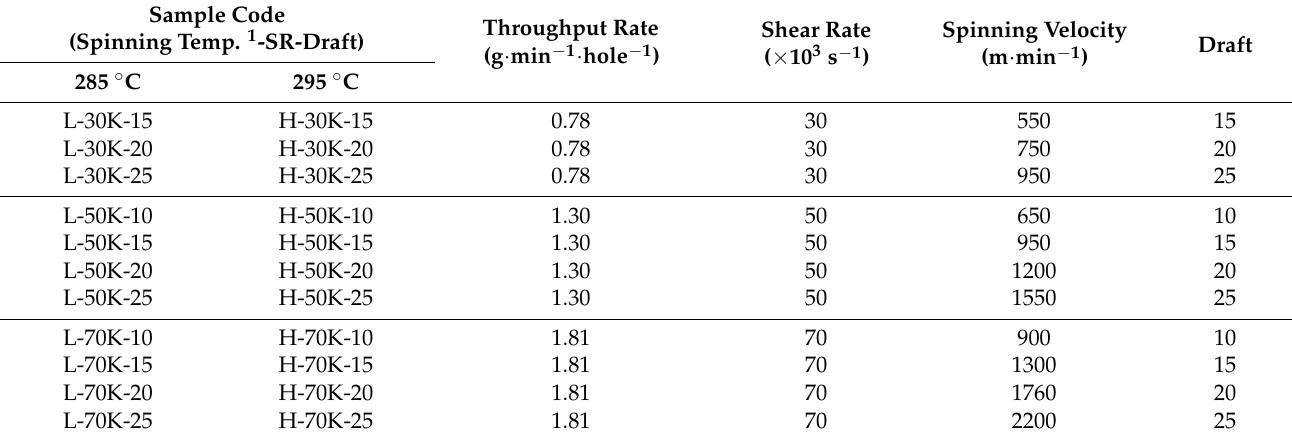
Table 1. Sample codes of as-spun TLCP fibers obtained at various spinning conditions. Sample